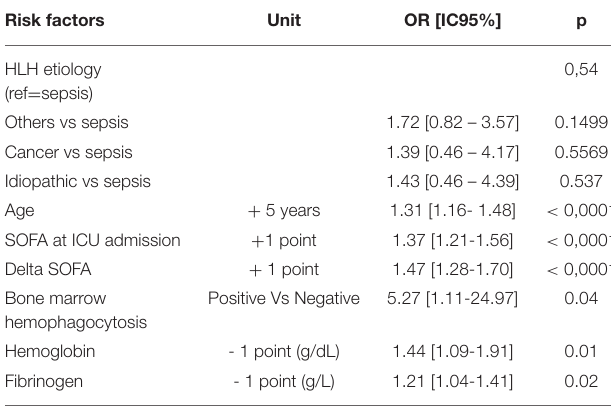
TABLE 4 | Multivariable analysis: mortality risk factors in ICU acquired adult HLH- logistic